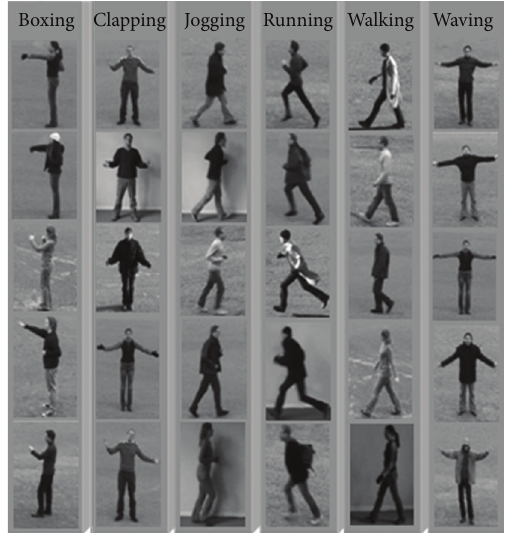
Figure 4: The figure depicts KTH human action dataset. To test the recognition of biological movements one of the well- known human action recognition datasets has been utilized in its performance. Here, the set represents KTH human action dataset. It isnoticeabletomentionthatKTHdatasetisoneofthelargesthuman action datasets having six various human actions in four different